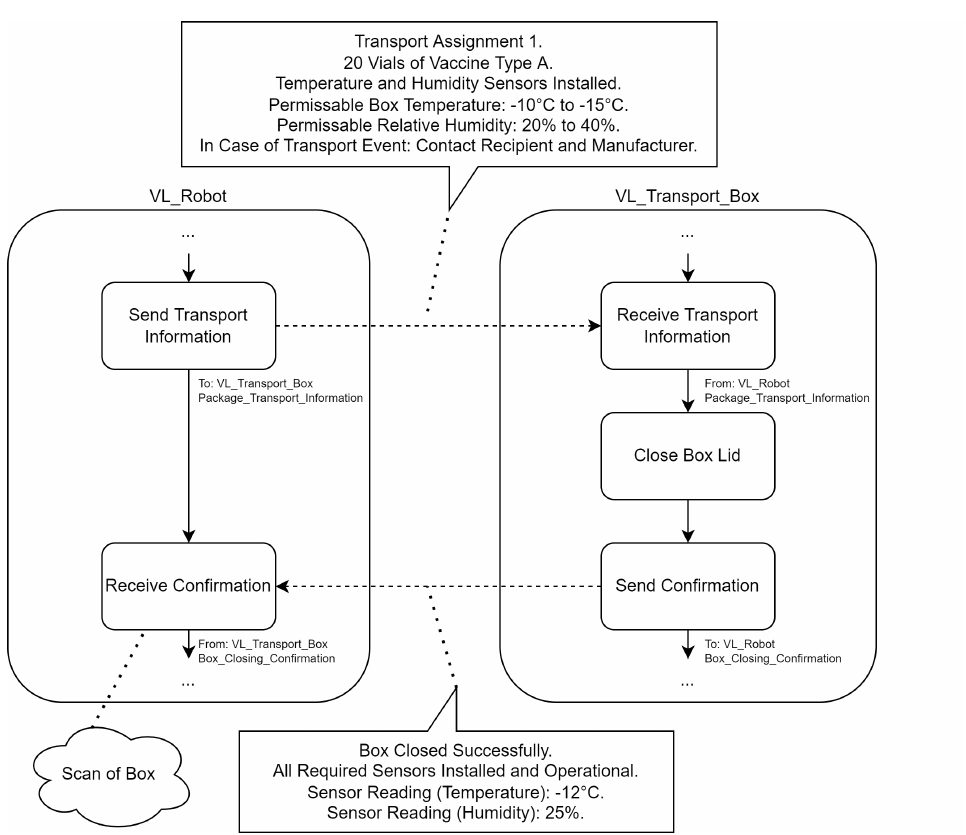
Figure 11. An example for the monitoring of the standard behavior of components and the related data. Data that concerns both a send state and a receive state was associated with the message connecting the